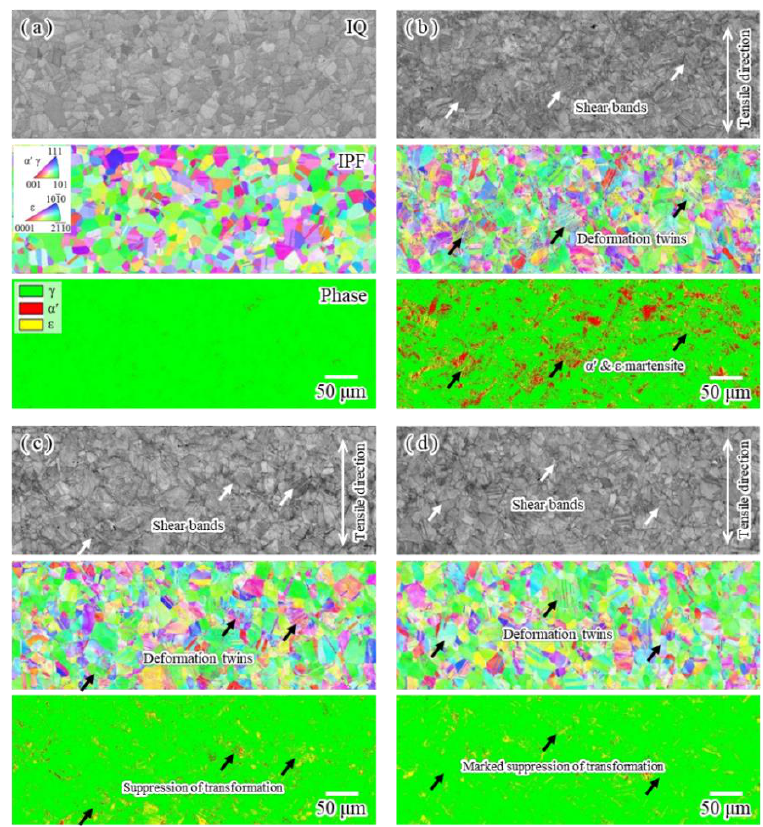
Figure 11. EBSD maps (IQ, IPF and phase maps) of surface of ( a ) uncharged specimen before tensile test and specimens subjected to tensile straining to 0.2 and unloading at −196 °C; ( b ) uncharged specimen, ( c ) conventionally charged specimen and ( d ) specimen charged by modified method.